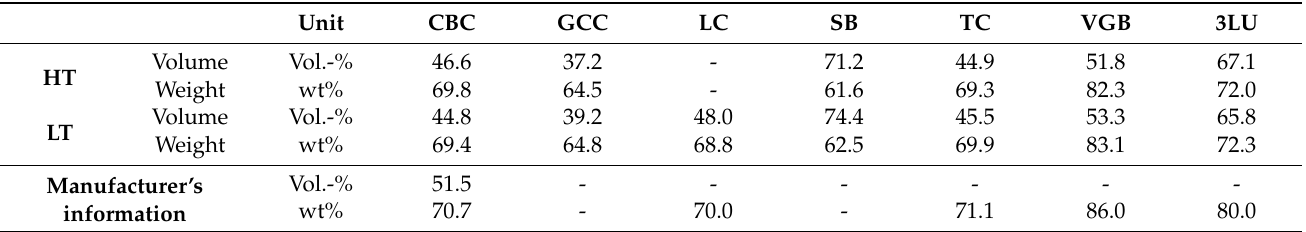
Table 3. Inorganic content by weight (identified by thermogravimetric (TG) analyses) and volume (identified by SEM image analyses) in comparison to the specifications issued by the manufacturers.